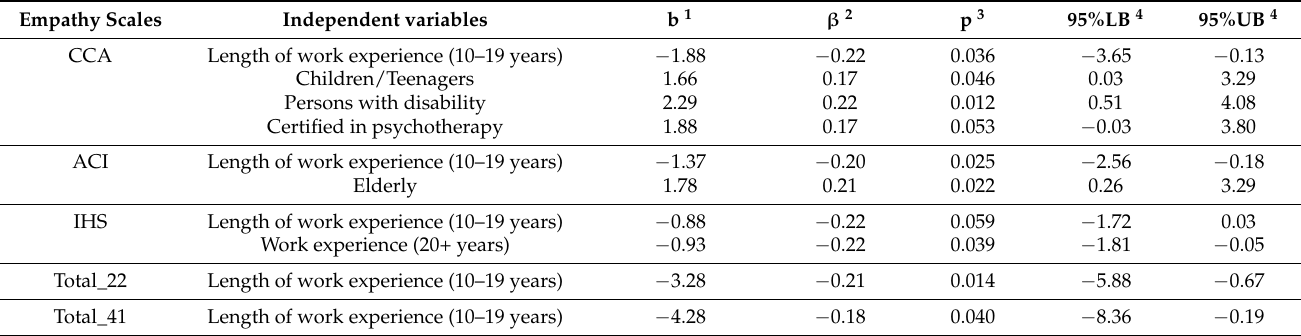
Table 6. Correlates of empathy as derived from multiple linear regression analysis with backward selection. Empathy